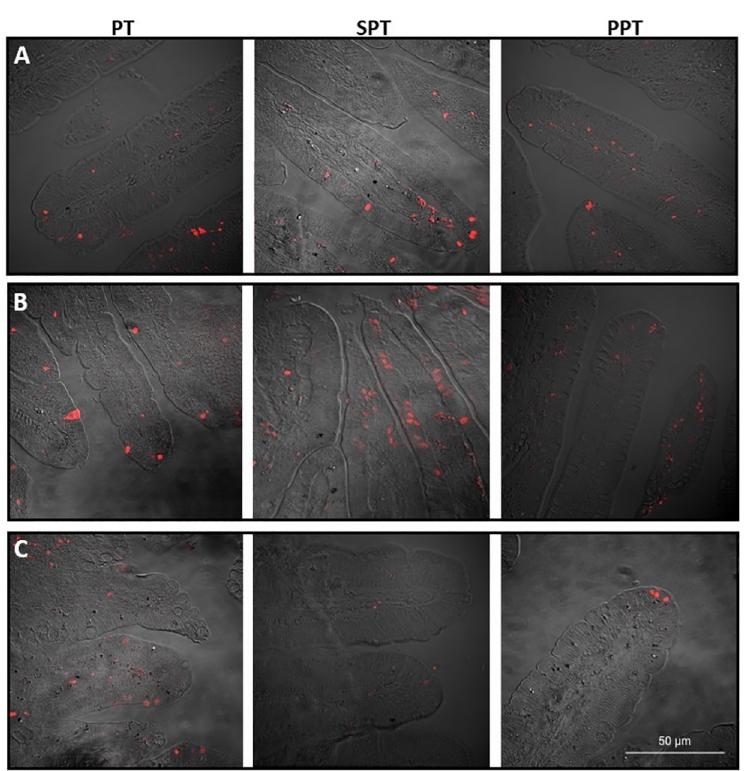
Fig 4. Apoptotic activity in the small intestinal villi. PT—14-day old intact, control preterm piglets, SPT—preterm piglets fed infant formula, PPT—preterm piglets fed pre-hydrolyzed infant formula. The images show visible apoptotic cells (colour—red) labeled with terminal deoxynucleotidyl transferase-mediated deoxyuridine triphosphate nick end labeling assay. A—proximal, B—middle, C—distal, section of the jejunum. Images were obtained using a confocal microscope (LSM5 Pascal, Zeiss, Germany, magnification—400 ×